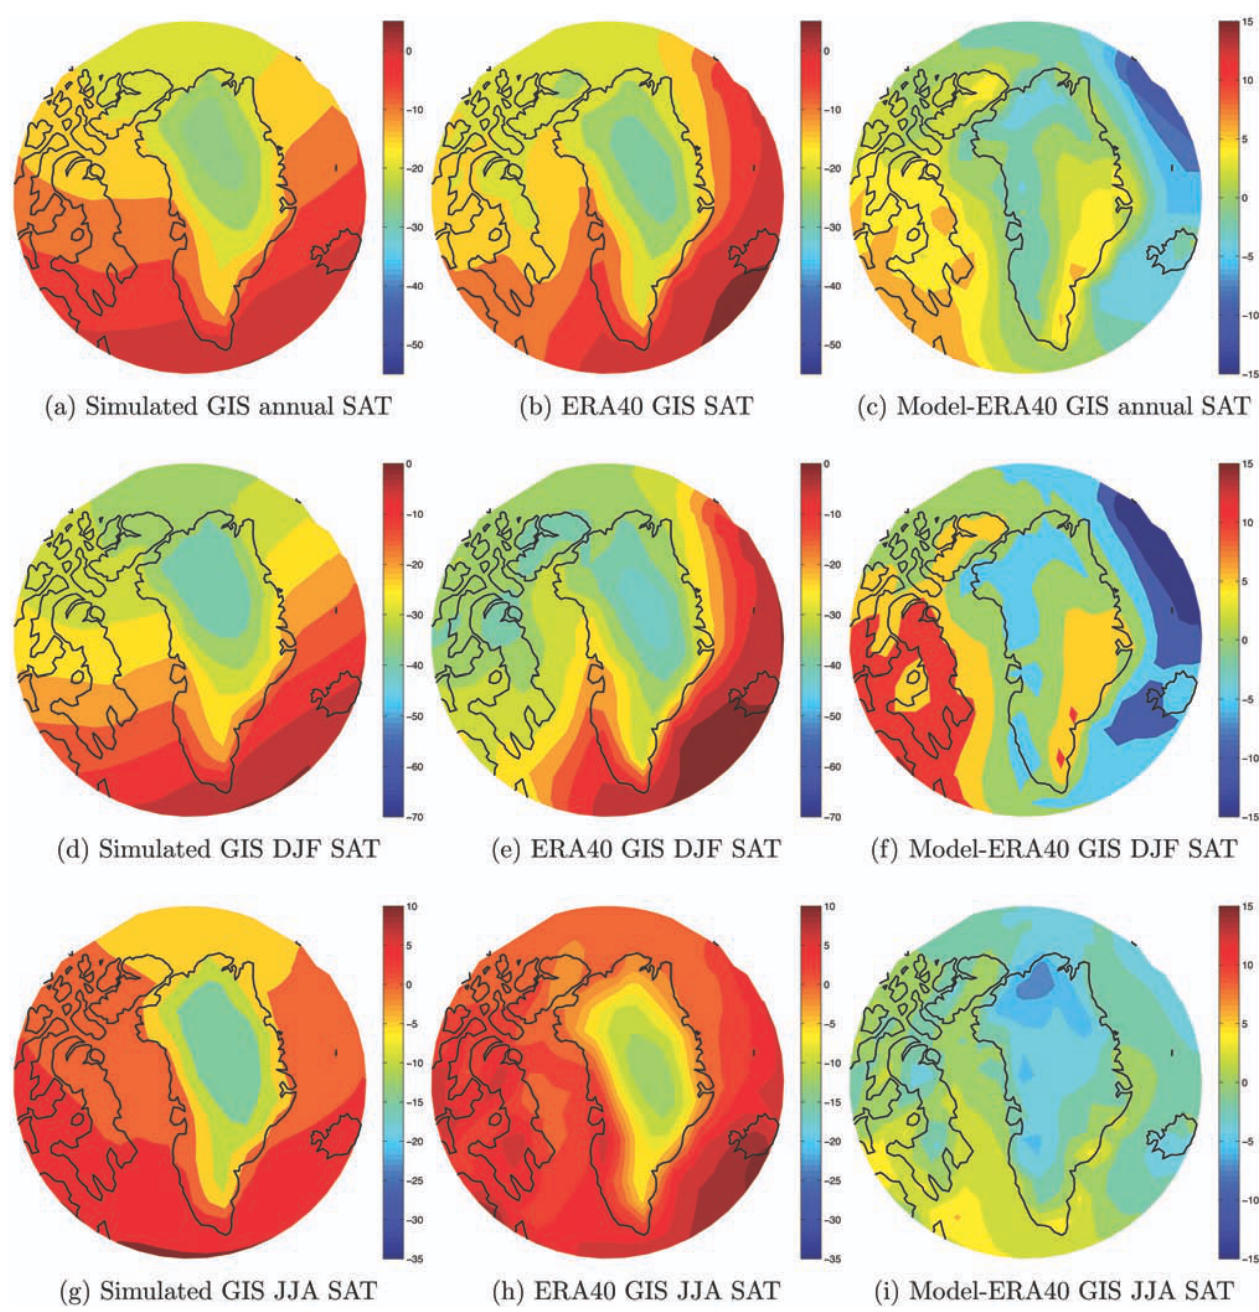
Fig. 8. Simulated/ERA40 1970–2001 annual, June-July-August (JJA) and December-January-February (DJF) average SAT over the Green- land Ice Sheet ( ◦ C). Note the different color scales for each seasonal